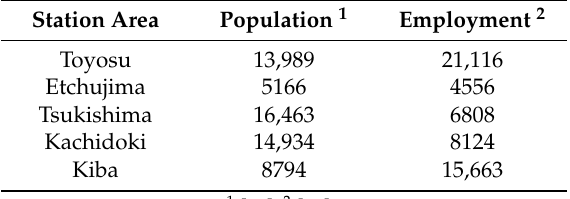
Table 3. Population and employment of Toyosu, Etchujima, Tsukishima, Kachidoki, and Kiba station